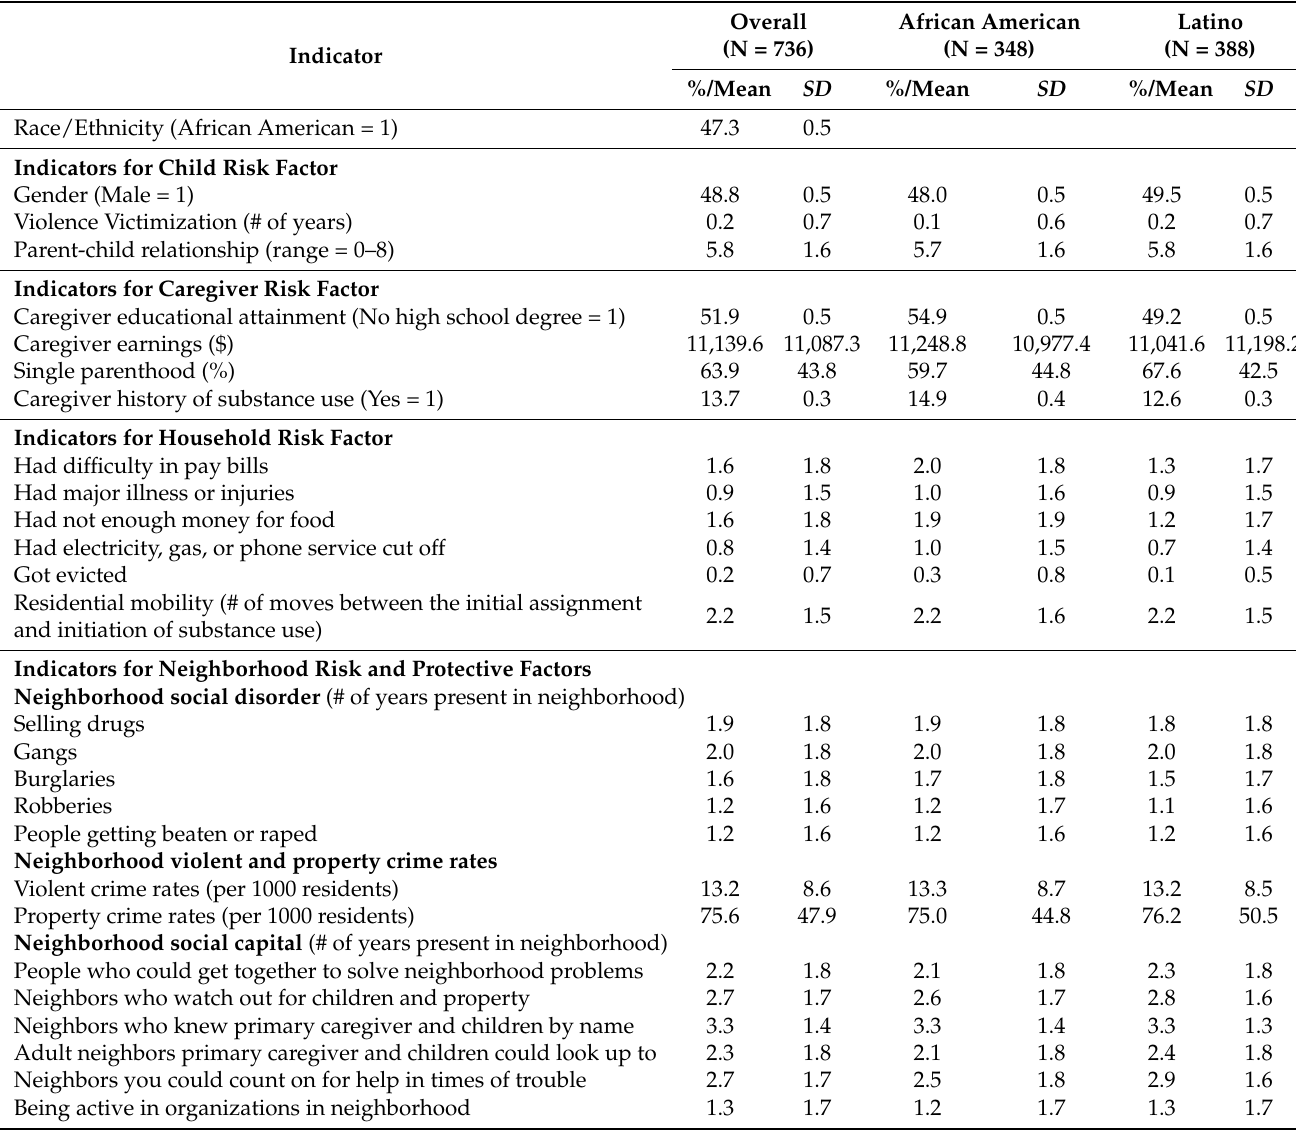
Table 1. Descriptive statistics for full sample and by Latinx and African American ethnicity.